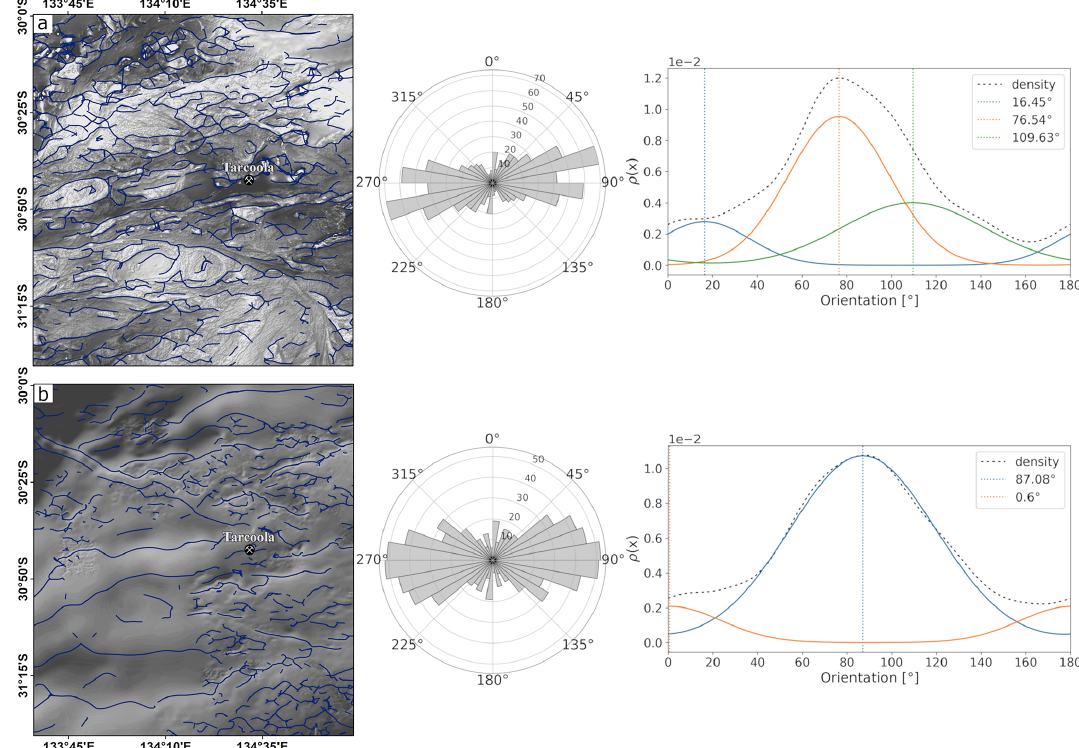
Figure 8. (a) Automatic gradient extraction with an upward continuation to 2070m performed on the total magnetic intensity after pole reduction. To the right of the map the rose diagram shows strike distribution with a bin size of 10 ◦ , and the Gaussian functions fitted to the probability density function are shown. (b) Automatic gradient extraction with upward continuation to 930m for gravity data. To the right the rose diagram visualising the orientation distribution and the model fitted to the probability density function are shown. Upward continuation heights of the gravity and magnetic data were selected such that the lineaments represent similar